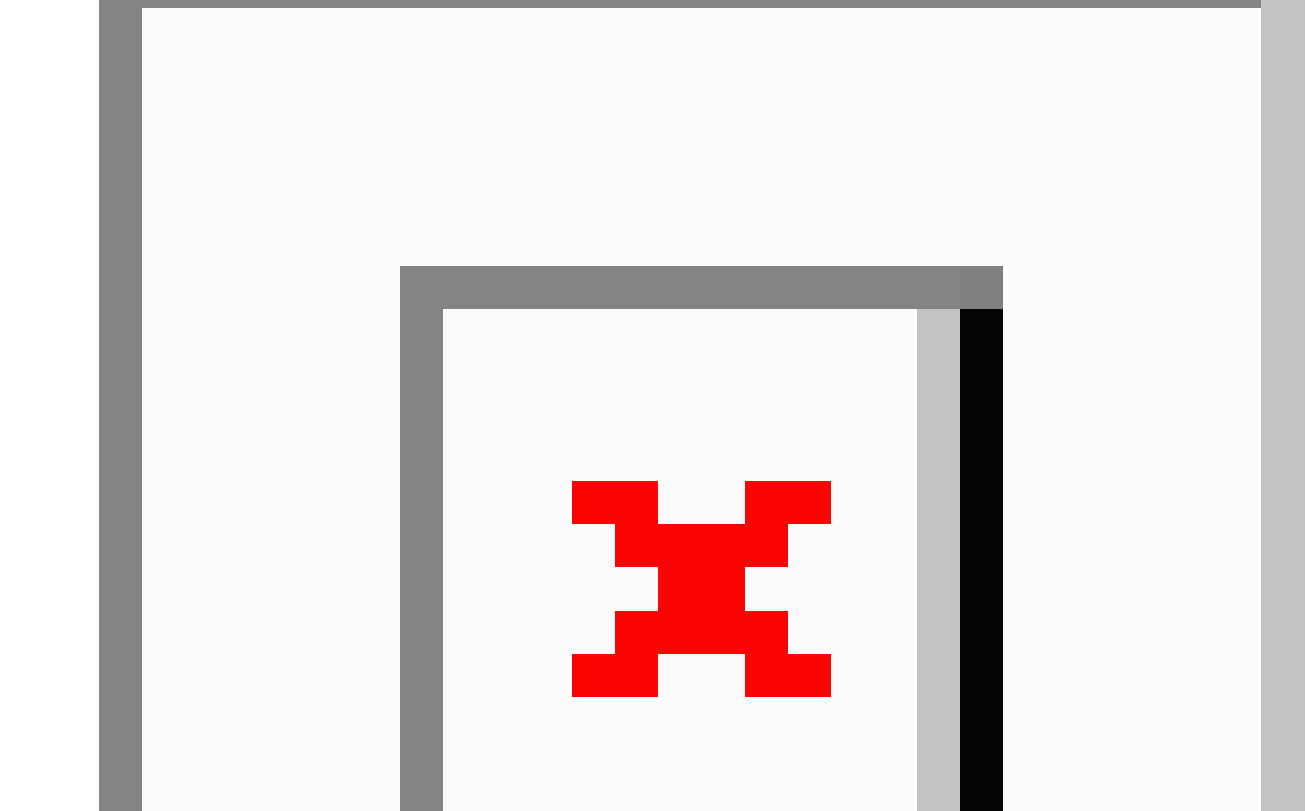
Figure 3. FOCUS partnerships by